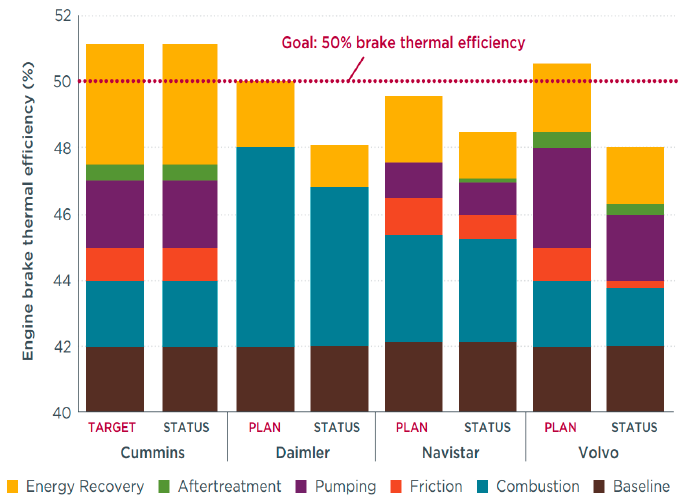
Figure 22. Brake thermal efficiency targets for super-trucks [378].